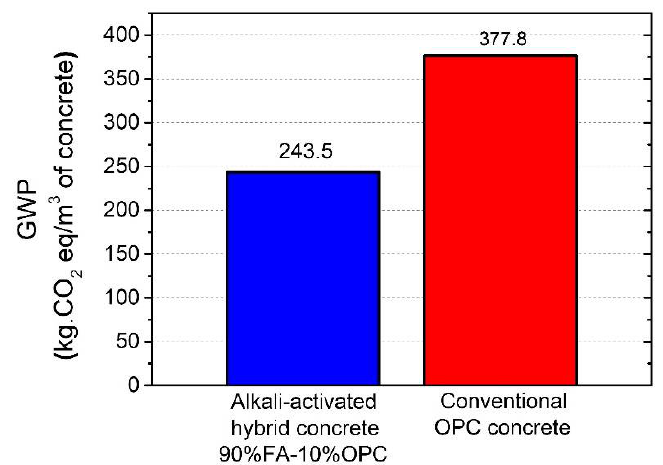
Figure 16. Impact of global warming potential index (GWP) projected over the next 100 years for alkali-activated hybrid concrete compared to conventional OPC concrete.